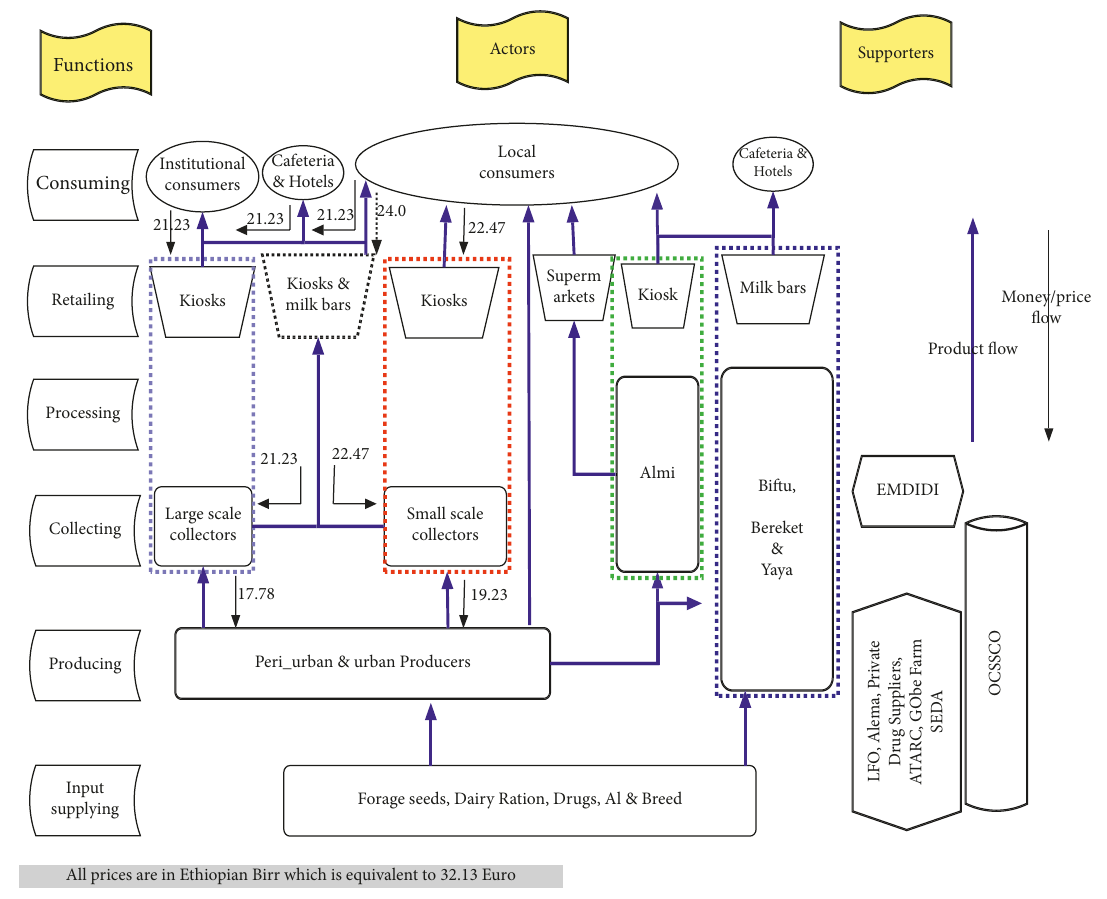
Figure 3: Dairy value chain map in Ziway-Hawassa milk shed. Table 2: Means of milk transportation during collection and distribution.